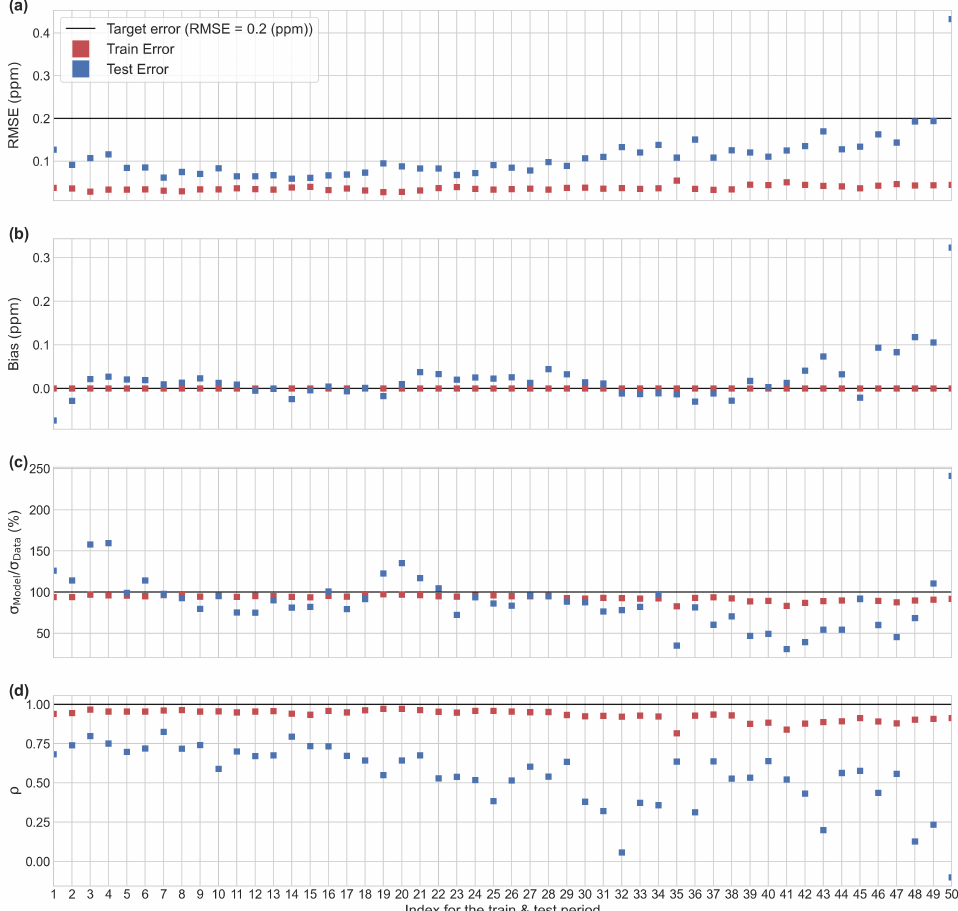
Figure 7. Performance of the MLP model for the 50 training and test periods. ( a ) RMSE on hourly data. ( b ) Mean bias. ( c ) Ratio between the spread of the predicted outputs ( σ Model ) and the spread of the true values ( σ Data ). ( d ) Correlation coefficient between the predicted outputs and the reference values.